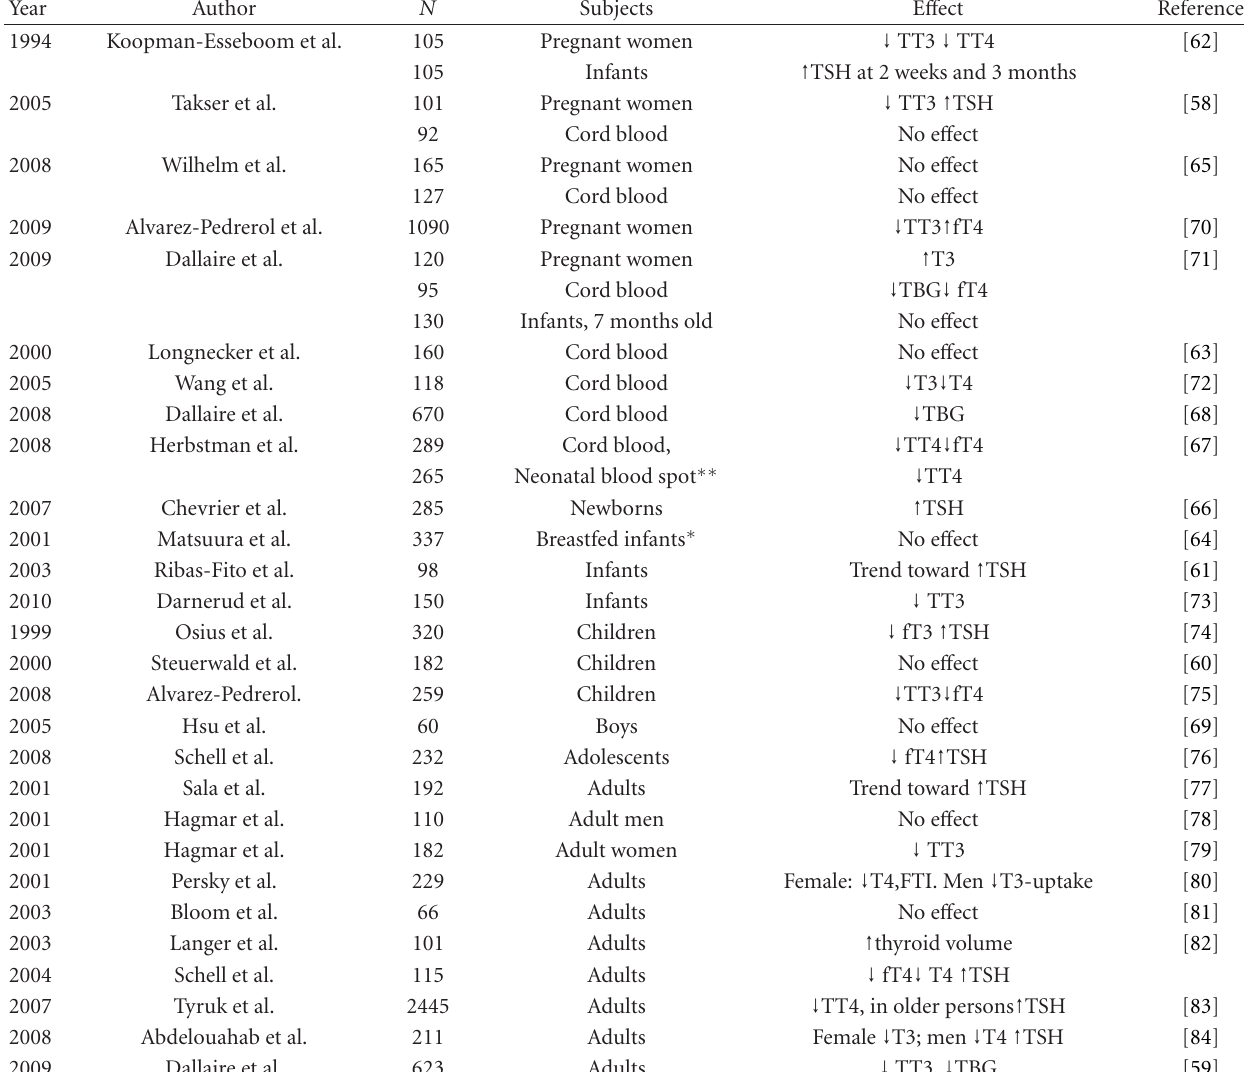
Table 2: Thyroid-disrupting properties of polychlorinated biphenyls in human studies on pregnant women, neonates, infants, adolescents, and